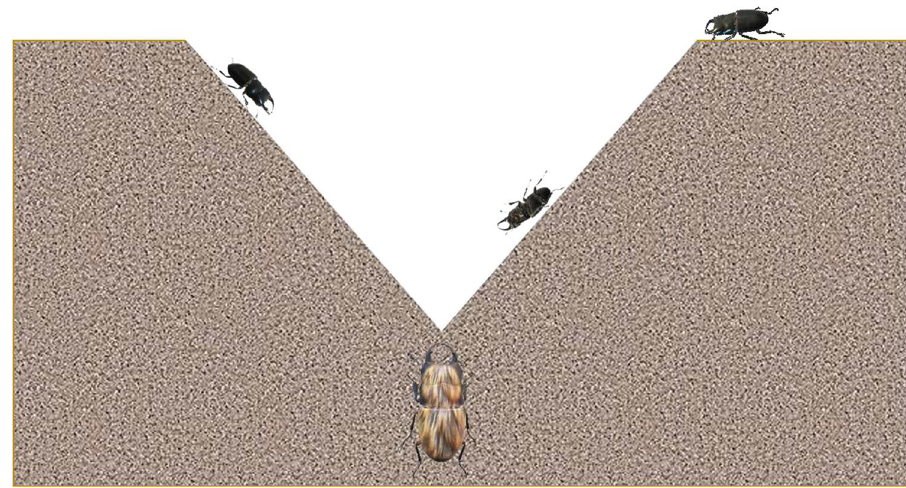
Fig. 1 Hunting behavior of